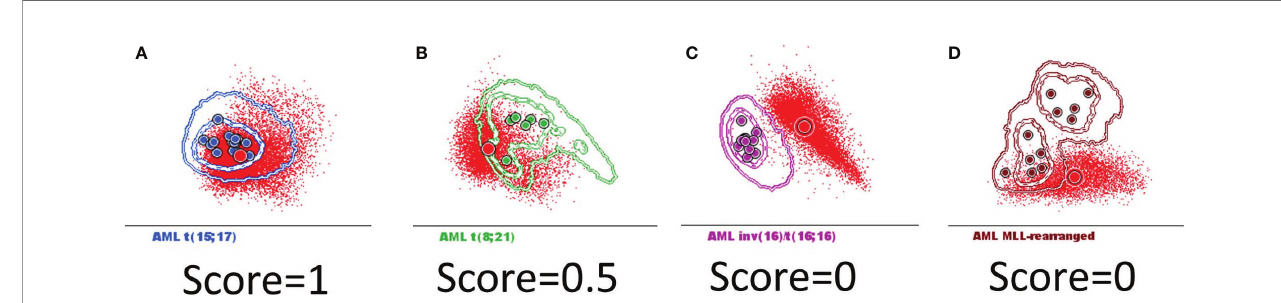
FIGURE 4 | The scoring system used to determine whether AML blasts from a new case can be classi fi ed in the de fi ned AML groups harboring recurrent genetic abnormalities that were included in the Compass databases. Acute myeloid leukemia (AML) blasts from a new case (red dots and circles) were compared with the AML groups included in the databases: t (15;17) AML (blue), t (8;21) AML (green), inv(16)/ t (16;16) AML (violet), and MLL -r AML (dark red). The circles represent the median values of individual cases. The dotted line represents the 1 standard deviation (SD) curve, and the solid line represents the 2 SD curve for the AML group. The similarity between the two populations was scored based on the position of the median for the new case blast events relative to the 1 and 2 SD curves for the AML groups that were included in the database: (A) falling within 1 SD was scored as 1 point; (B) falling within 1 – 2 SDs was scored as 0.5 points; and (C, D) falling outside of 2 SDs was scored as